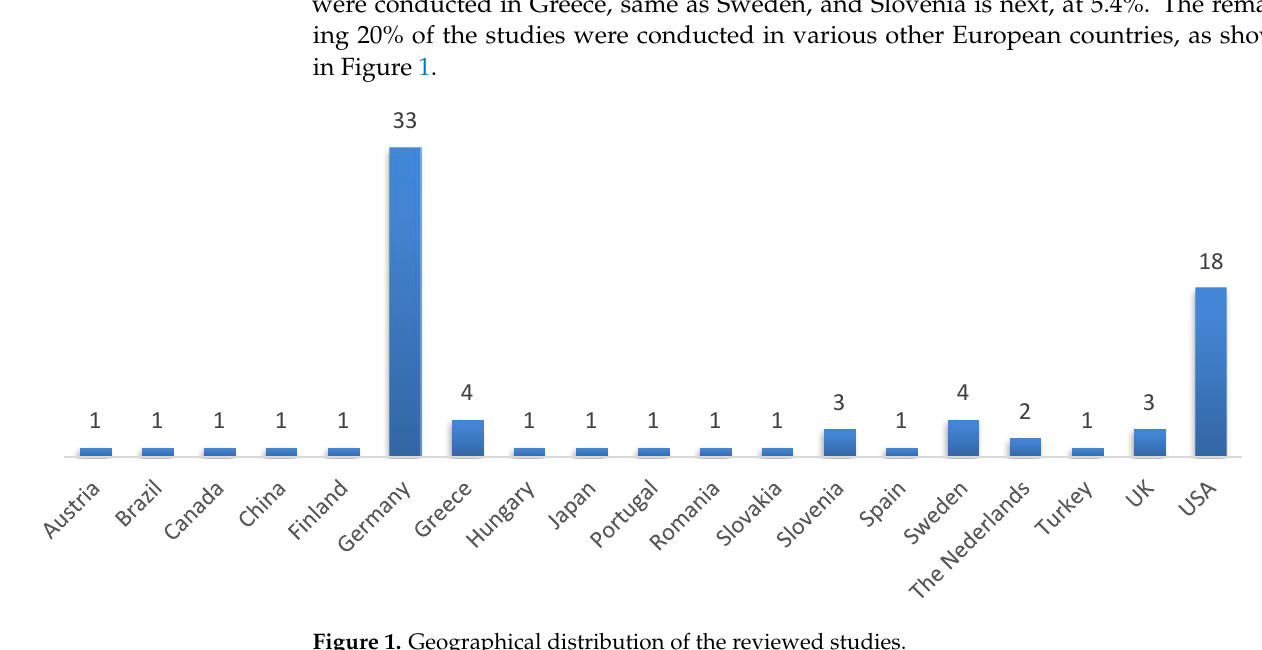
Figure 1. Geographical distribution of the reviewed studies.